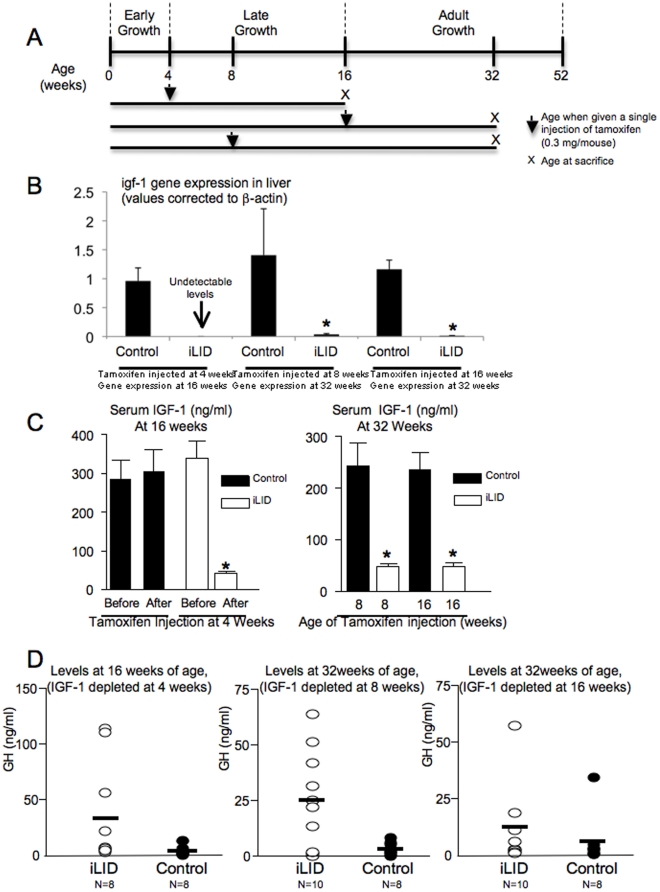
Experimental design, gene expression and serum levels for control and iLID mice.A) Schematic representation of the experimental design. (B) igf-1 gene expression in liver in control and iLID mice injected with tamoxifen at different ages (C) Mean serum IGF-1 levels (± s.d) in control (n = 6) and iLID (n = 6 each) before (4 weeks) and after (16 weeks) injection of 0.3 mg of tamoxifen at 4 weeks. Serum IGF-1 levels in iLID mice are statistically different from control mice as expected (ANOVA, p<0.05). (D) Serum GH levels in control (n = 8) and iLID mic (n = 10) after depletion of serum IGF-1 by tamoxifen injection.